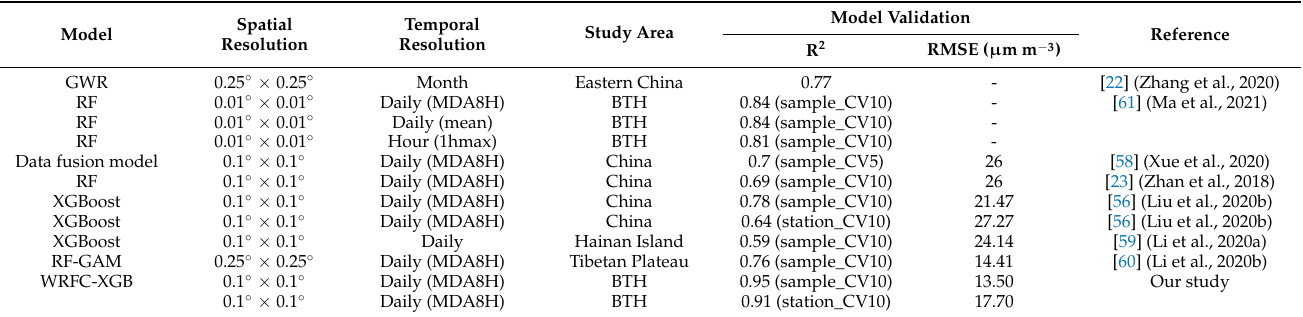
Figure 6. Sample-based and station-based 10-fold CV results of traditional statistical models and the WRFC-XGB model. Red dots indicate the estimation results of the fusion of these models (traditional statistical models and the WRFC-XGB model) with the WRF-Chem model. Blue dots indicate that only these models are used. Table 3. Comparison of the O 3 estimation accuracy between the WRFC-XGB model and the models used in previous